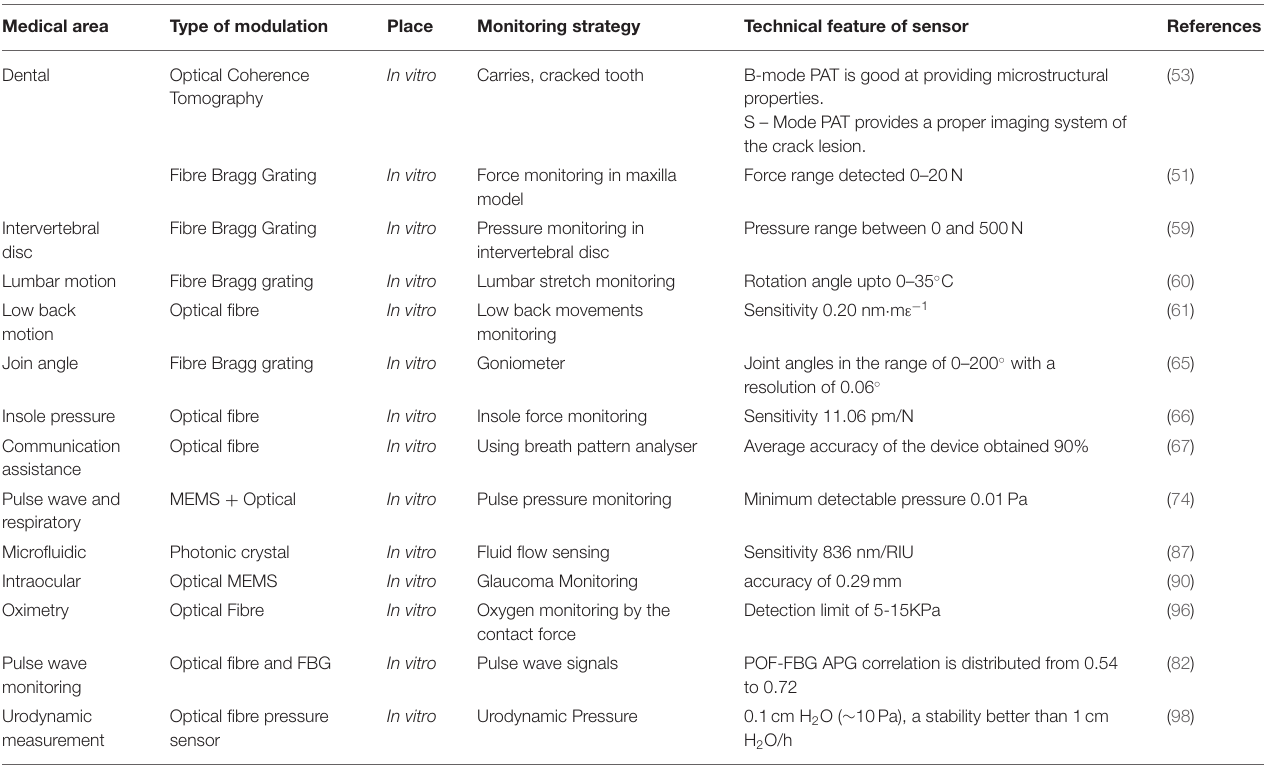
TABLE 2 | Key applications of Optical MEMS in biomedical. Medical